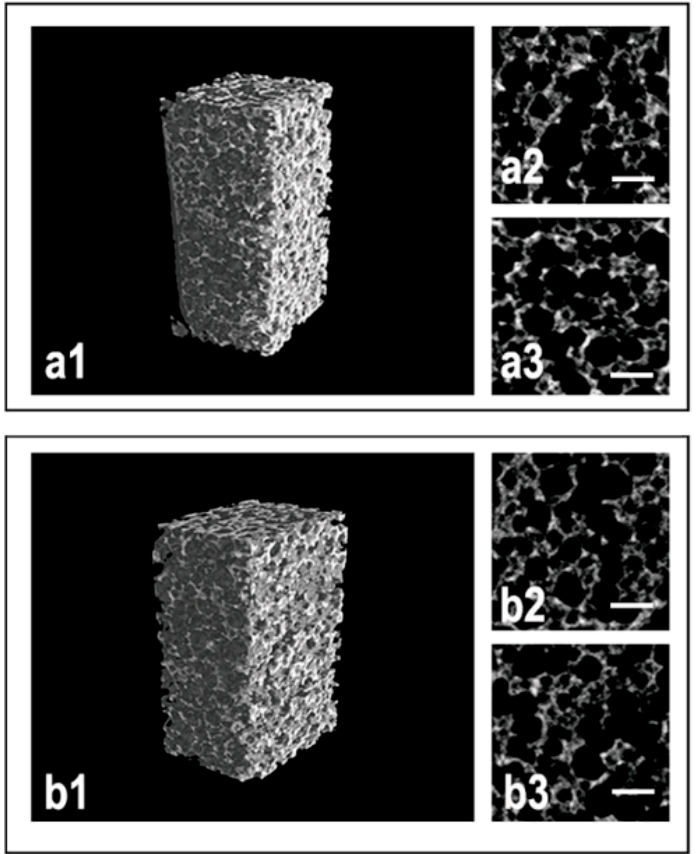
Figure 2. MicroCT analysis of the traditionally sintered biomaterials: ( a1–a3 ) Sintered@ T = 1150 °C sample; ( b1–b3 ) Sintered@ T = 1280 °C sample—3D reconstruction ( a1 , b1 ) after compressive loading,